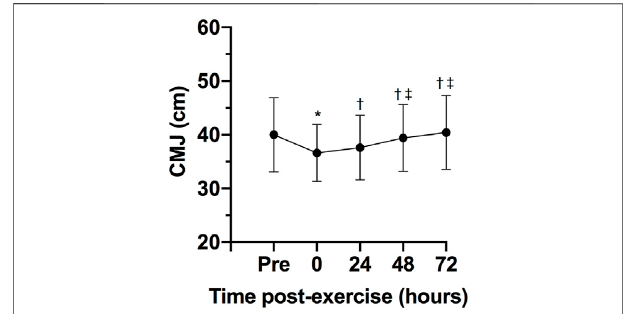
FIGURE4| Variablesareexpressedasmeanandstandarddeviation(±). Height of counter movement jump (CMJ) during pre-test, post-test, 24, 48 and72 hpost-test;* p ≤ 0.05forpre-exercise; † p ≤ 0.05for0-hpost-exercise; ‡ p ≤ 0.05 for 24-h post-exercise.